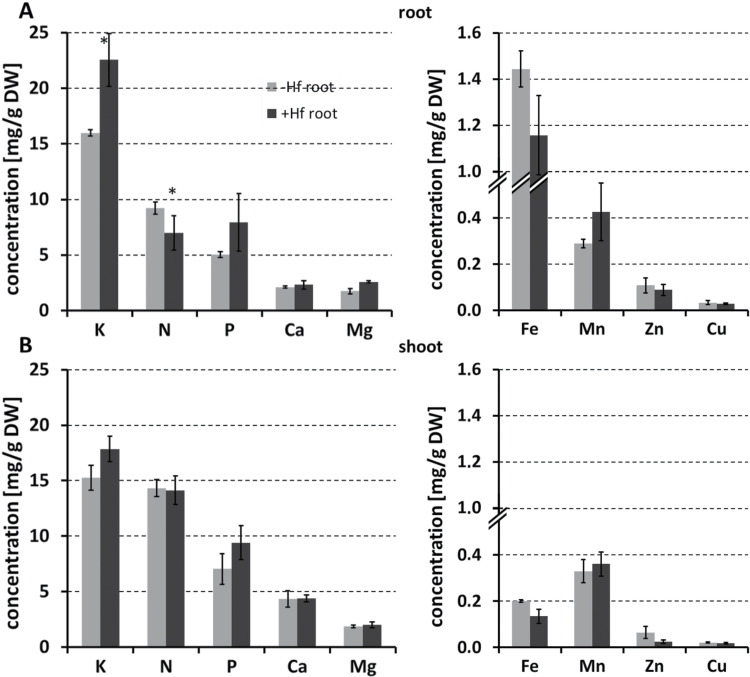
Differential element concentrations in roots (A) and shoots (B) without (grey bars) and with (black bars) H. frisingense inoculation. Macroelements (left graphs) and micronutrients (right graphs) are given in concentrations [mg/g dry weight (DW)]. Asterisks indicate significant differences at the P < 0.05 level (one-way ANOVA).